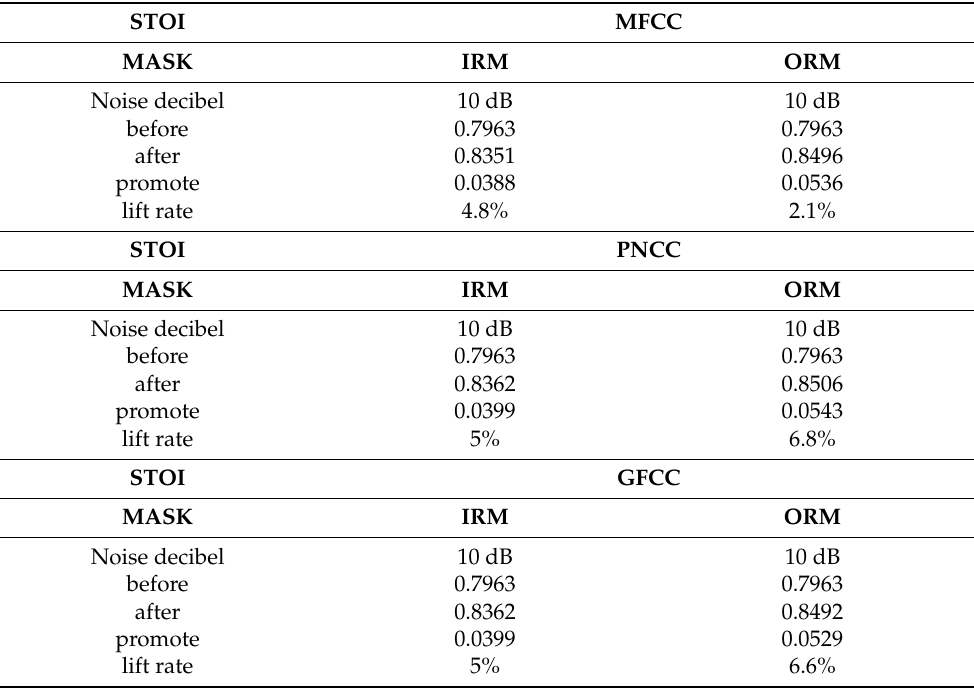
Table 6. Feature Extraction Method and Mask Comparison